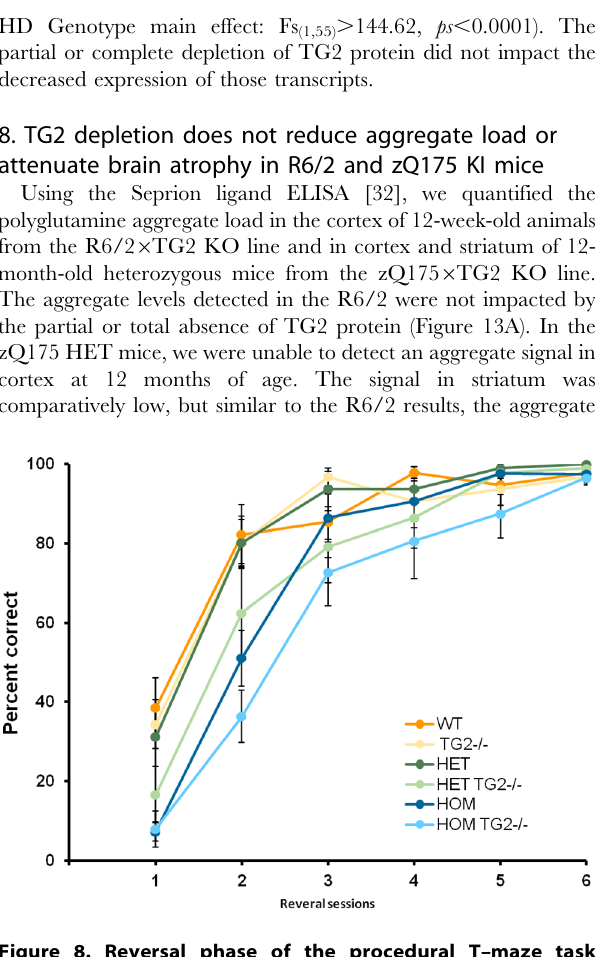
Figure 9. Mean number of days required to obtain 40 reinforcers across two consecutive sessions during the training phase (n=6–12 per genotype). *Significant HD genotype effect. WT: wild-type, TG2 2 / 2 : homozygous TG2 knockout, HET: zQ175